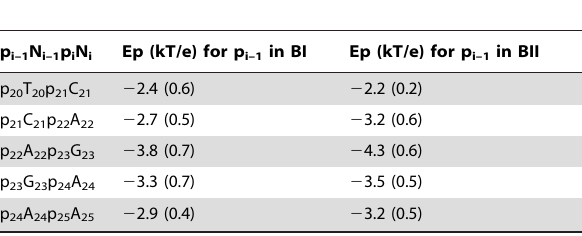
Table 2. Electrostatic potential values at cation locations in the DNA major groove.